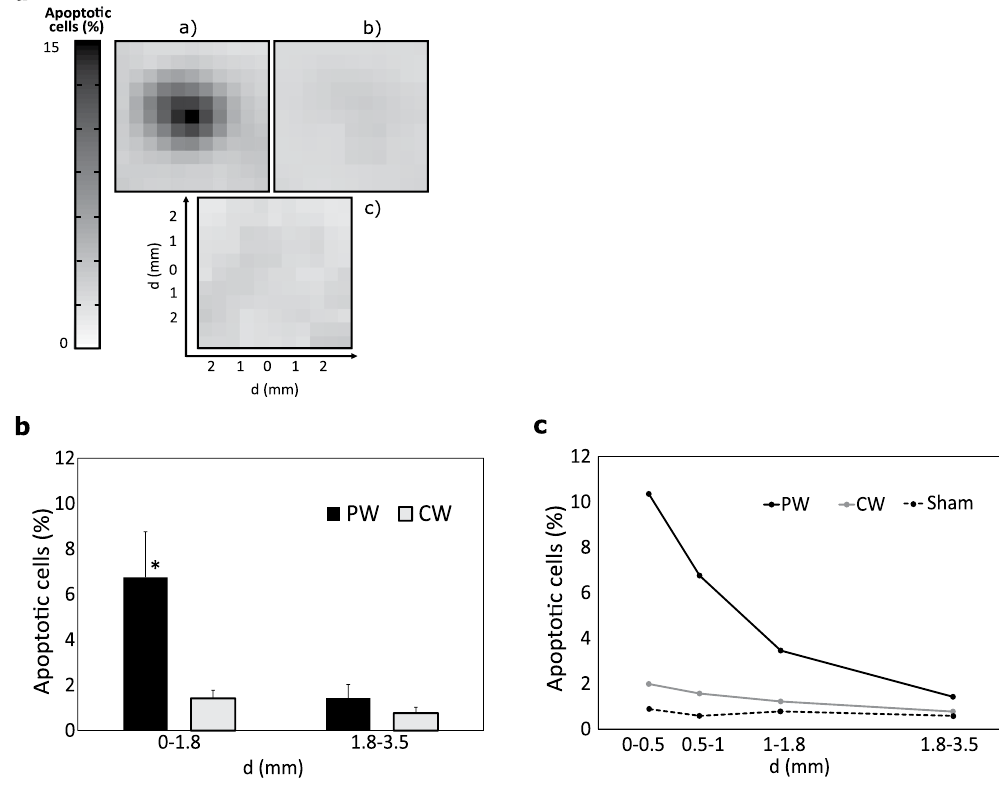
Figure 3. Percentage of apoptotic cells after PW and CW exposure with the same average temperature rise. ( a ) Spatial distribution of apoptotic cells for ( a ) PW, ( b ) CW, and ( c ) sham exposures. ( b ) Apoptotic response analyzed cell-by-cell 6 h post exposure shown as mean values (n = 3) ± SEM normalized to the sham. The data are averaged over the areas around the center of the well (i.e. 0–1.8 mm denotes the data averaged over the area with the radius of 1.8 mm, and 1.8–3.5 denotes the data averaged over 1.8 mm to 3.5 mm from the center). Asterisk ( * ) indicates statistical significance at p < 0.05. ( c ) The same data shown for the averaging with higher spatial